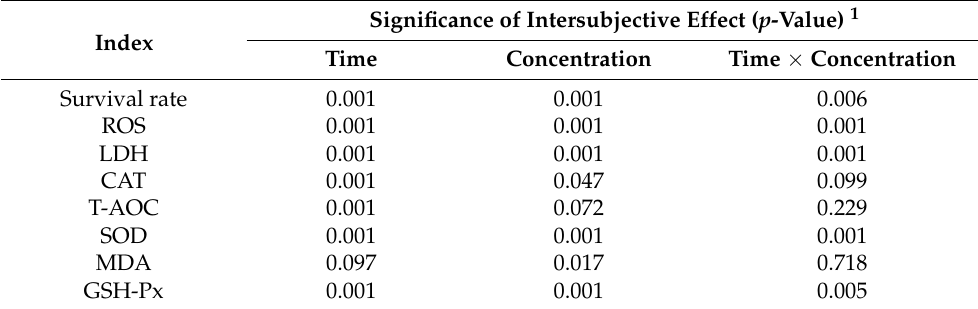
Table 16. The main effect and mutual effect of treatment time and concentration on each index.